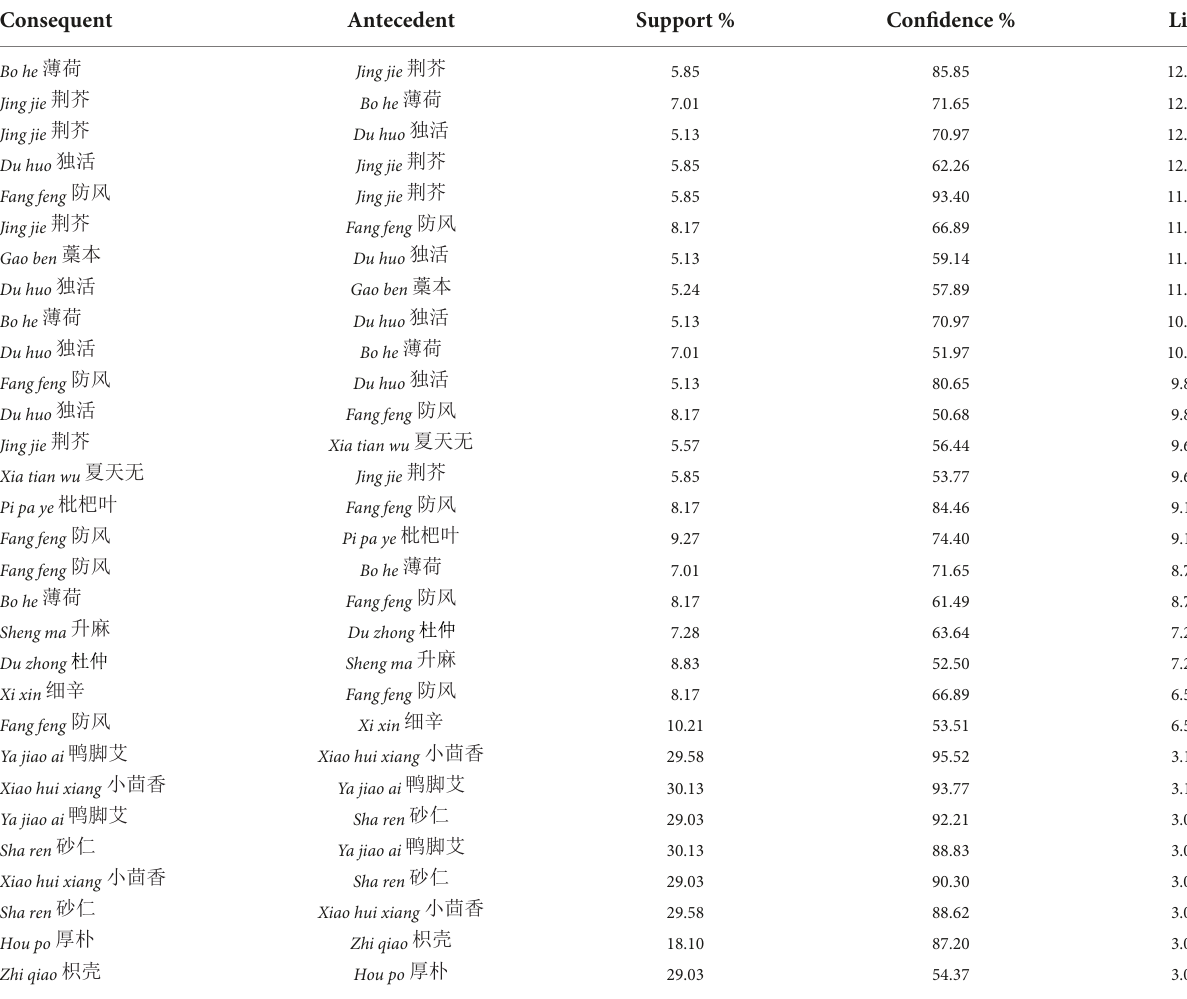
TABLE 5 Core herb pairs in Chinese herbal decoctions for which patients reported